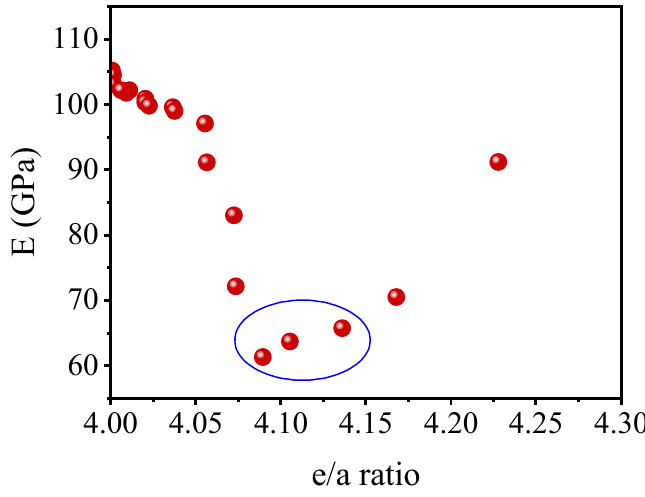
Figure 5. Expected structures of Ti alloys after a water quench with respect to electron-to-atom ratio scale [37].